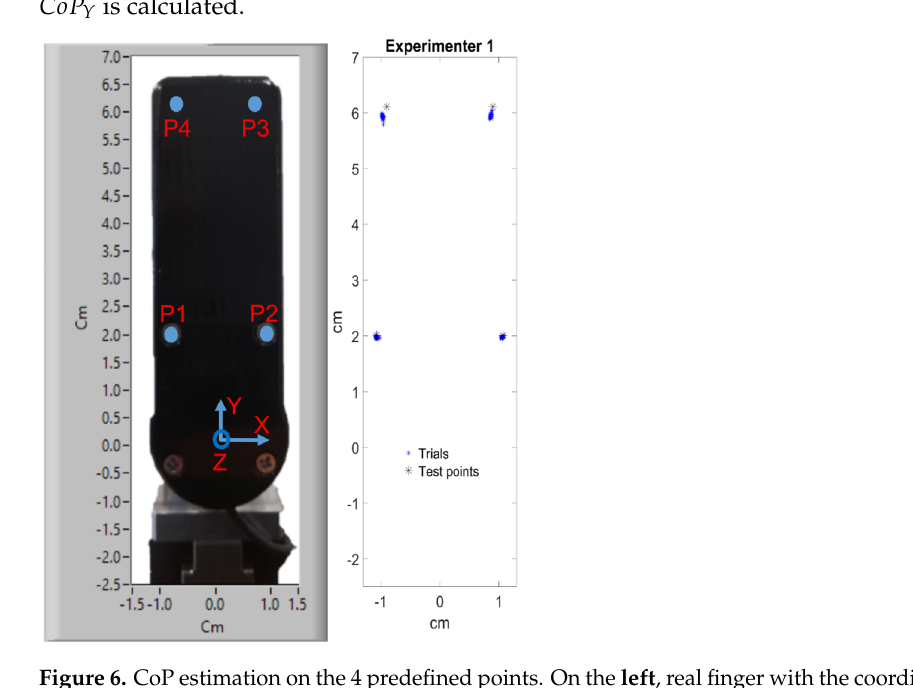
Figure 6. CoP estimation on the 4 predefined points. On the left , real finger with the coordinate frame and points. On the right , the cloud of reconstructed points (blue) and actual points (black asterisks).